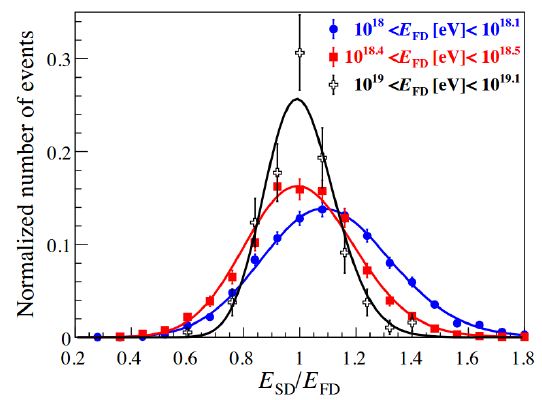
Figure 5. Exposure of the surface and fluorescence detectors.